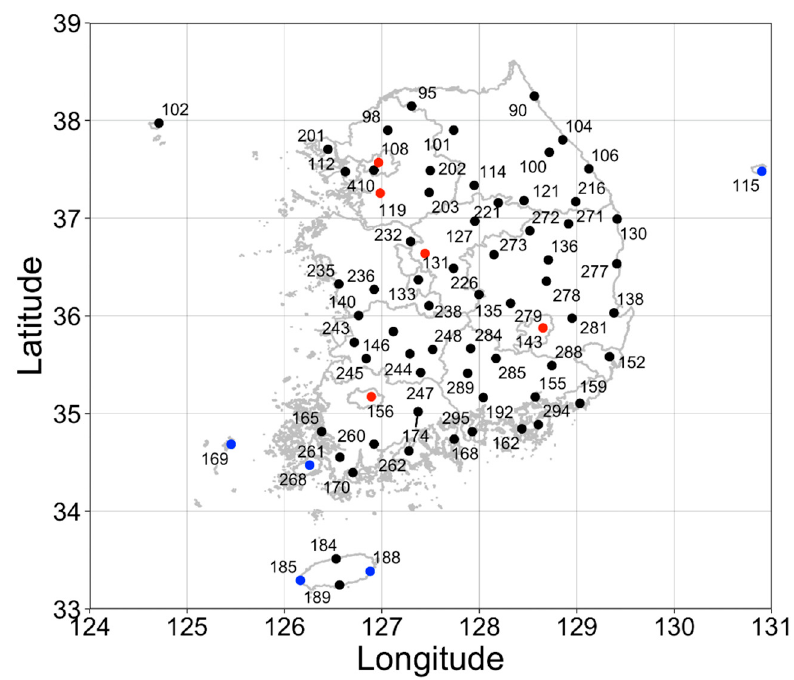
Figure 1. Location of the ASOS observation site in South Korea. Red and blue points indicate the representative sites in urban and island regions.